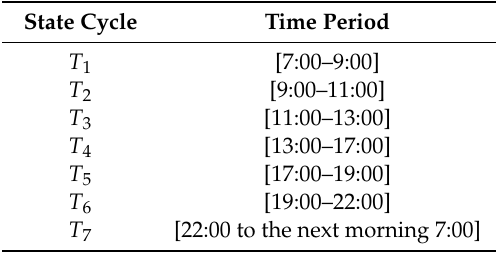
Table 2. Bike-sharing user single ride distance